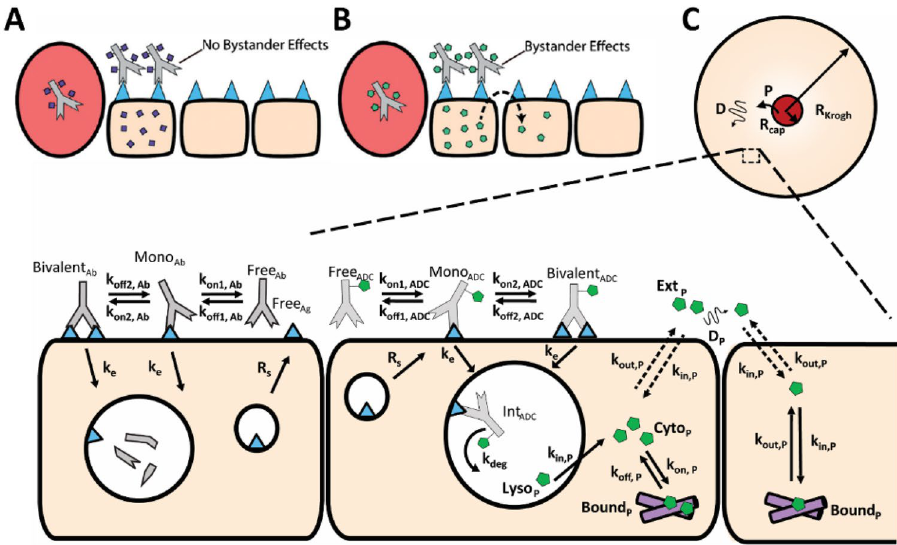
Figure 4. Simulating distribution of ADC payloads in vivo. ( A ) Schematic highlighting non-bystander payloads and cell killing with lysine-SMCC-DM1 (maytansinoid with a non-cleavable linker). ( B ) Schematic highlighting bystander penetration into surrounding cells using MMAE (monomethyl auristatin E). ( C ) Diagram of competition reactions between ADC and HALA antibody and payload distribution in the Krogh Cylinder